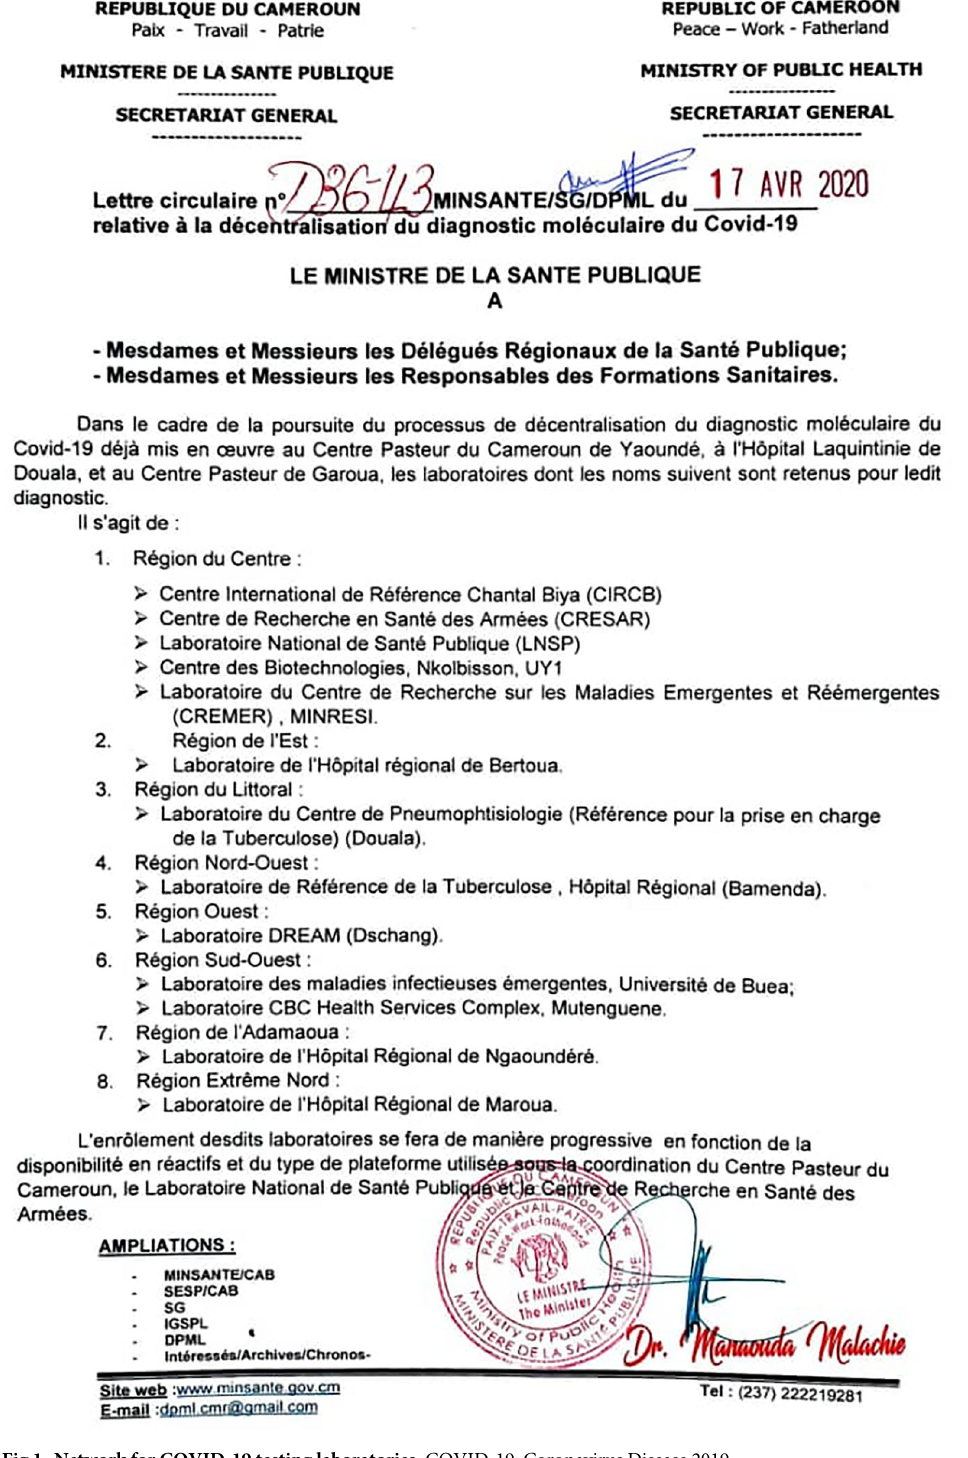
Fig 1. Network for COVID-19 testing laboratories. COVID-19: Coronavirus Disease 2019.